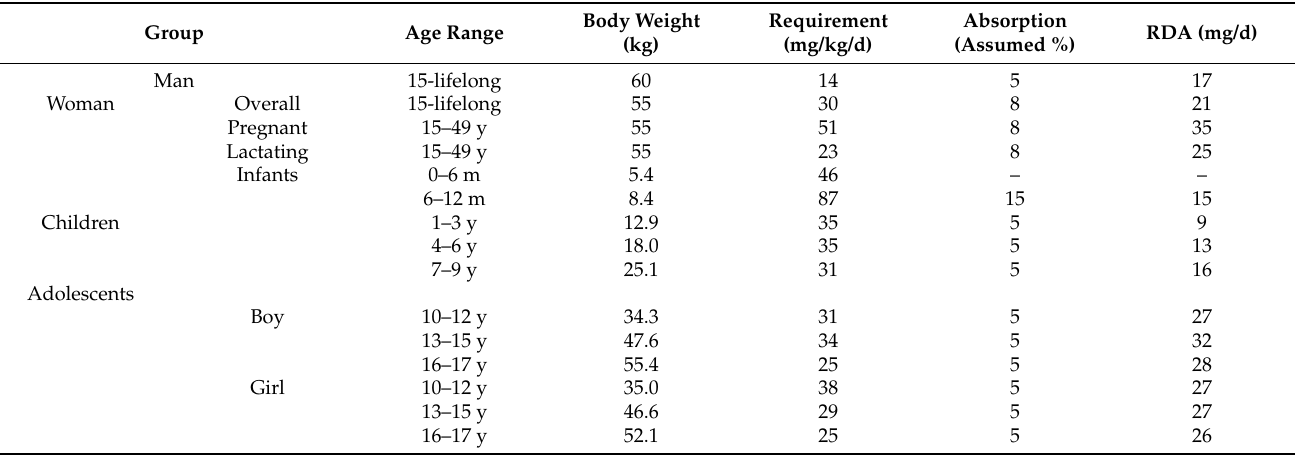
Table 3. RDA for iron in India. Y-year old; m- month. Source: RDA for Indians, Indian Council of Medical Research, 2010, India